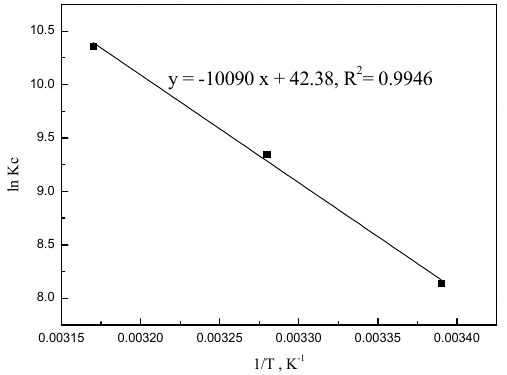
Figure 10. Plot of ln K c versus 1/T for adsorption of Pd(II) onto BISIN.